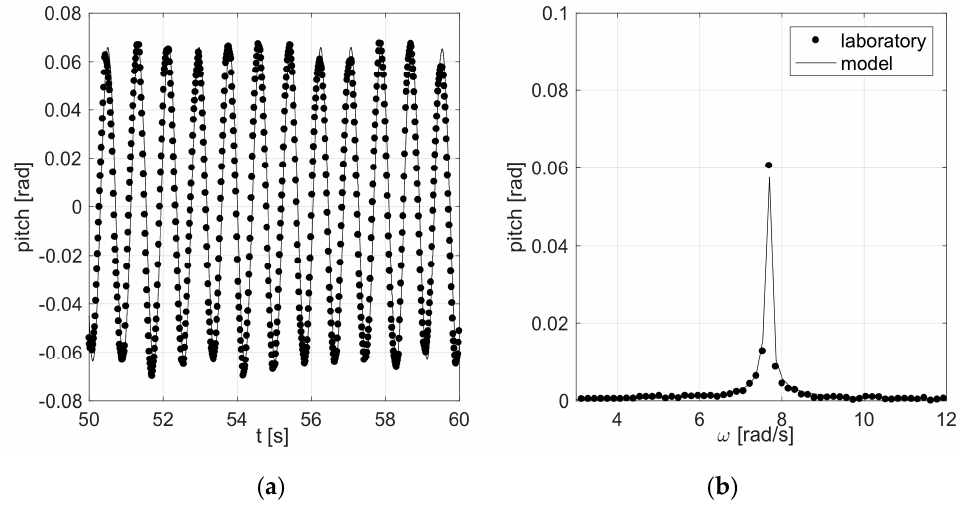
Figure 9. Pitch response during test R05: comparison between laboratory and model results of the time series of oscillation ( a ) and spectrum ( b ).